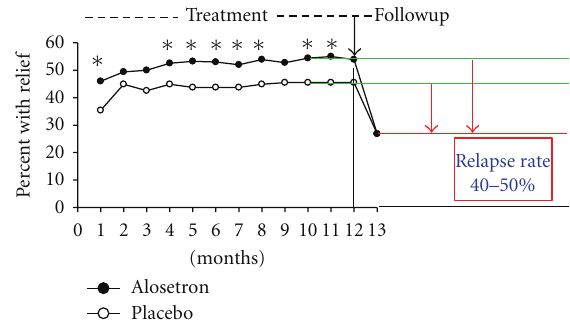
Figure 6: E ff ect of 1-year treatment with alosetron or placebo and percentage of patients with adequate relief after 1 month of followup. ∗ P < 0 . 05 as compared to respective placebo group. Modified from